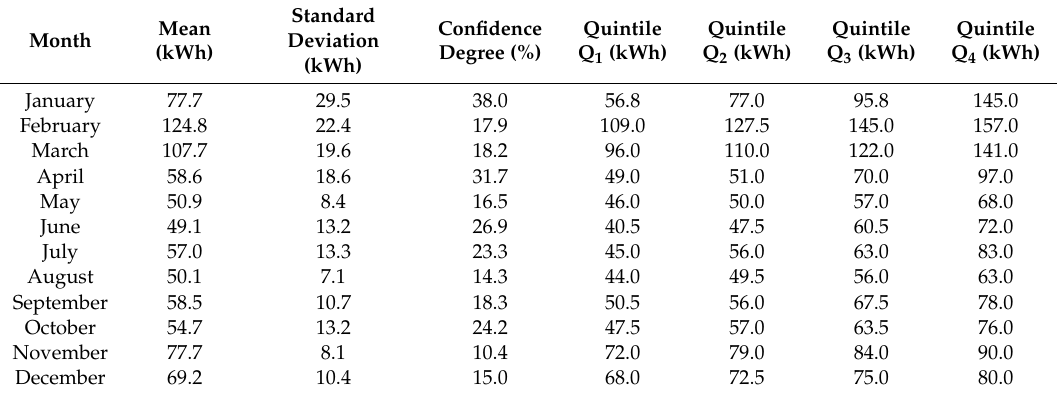
Table 5. The statistical results obtained for the daily energy consumptions from each month of the year